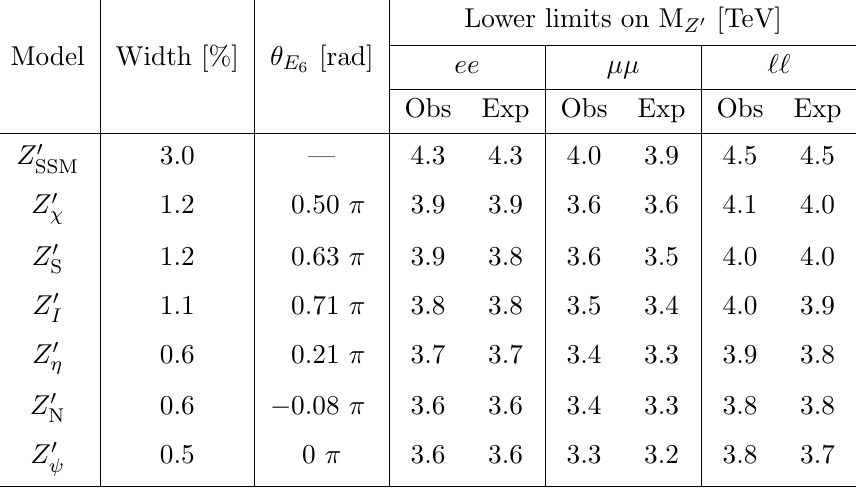
Table 5 . Observed and expected 95% CL lower mass limits for various Z 0 gauge boson models. The widths are quoted as a percentage of the resonance